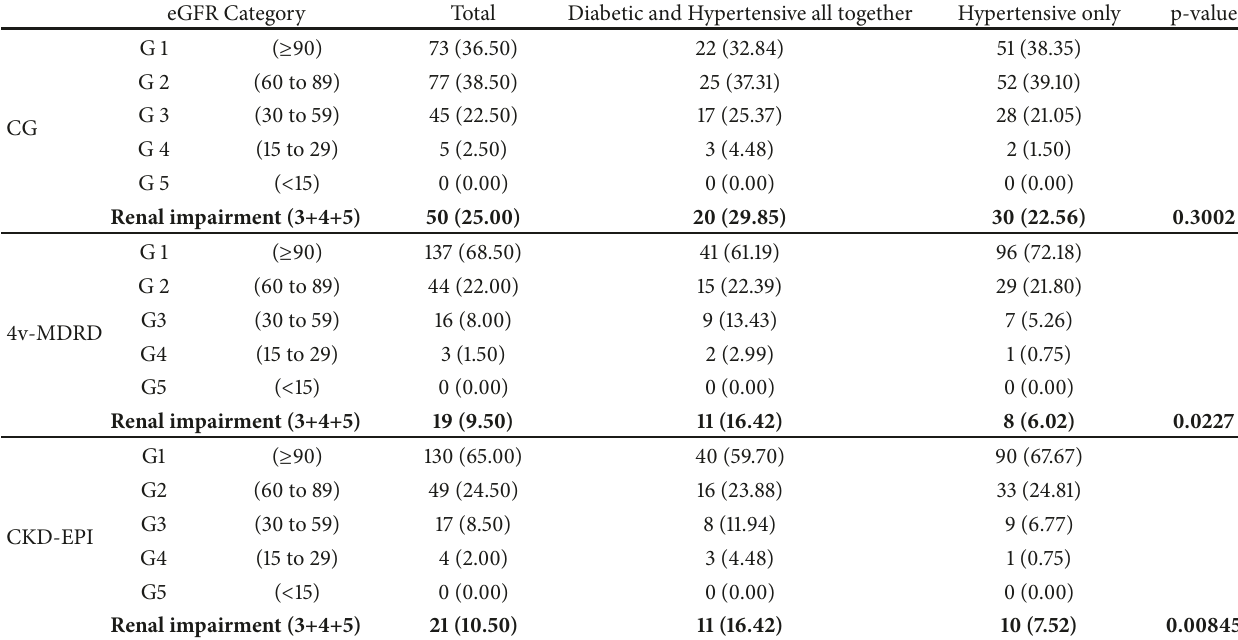
Table 4: Renal dysfunction categorization among study population using KDIGO eGFR Criteria stratified by disease status. eGFR